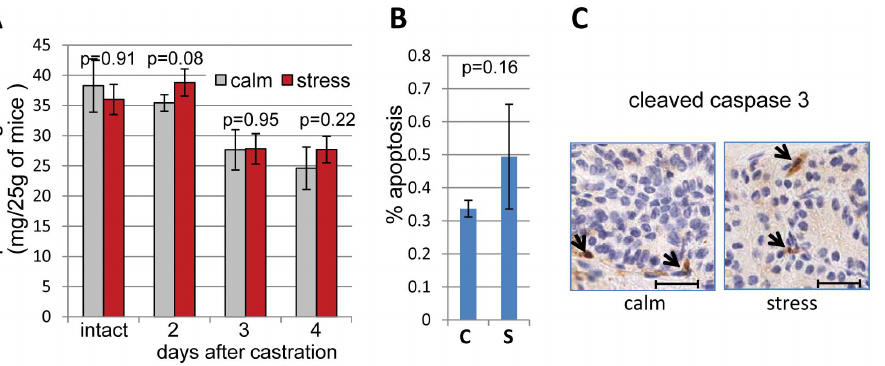
Figure 1. Behavioral stress fails to delay surgical castration-induced involution and apoptosis in mice prostates. A) Castration- induced prostate involution. Mice were either left intact (n=4) or surgically castrated and subjected to immobilization stress twice a day with 12 h intervals (stress) or not subjected to stress (calm). At 2, 3 or 4 days post-castration (n=3 for both calm and stress), prostates were excised, dissected, and weighted. Prostate weight decreased significantly by day 3 after castration (p=0.01). There were no significant differences in prostate weights between stressed and calm groups. B) Stress does not decrease apoptosis in castrated prostates. Apoptosis (expressed as percent cleaved caspase-3 positive cells) was determined relative to the total number of glandular epithelial cells in whole sections of dorsolateral prostate glands excised 3 days after castration in stressed (S) and calm (C) groups of mice (n=3 in each group). C) Representative images of cleaved caspase-3 IHC-stained sections from dorsolateral segments of the prostate from intact (calm) or stressed (stress) mice. Arrows point at caspase 3 positive cells. Scale